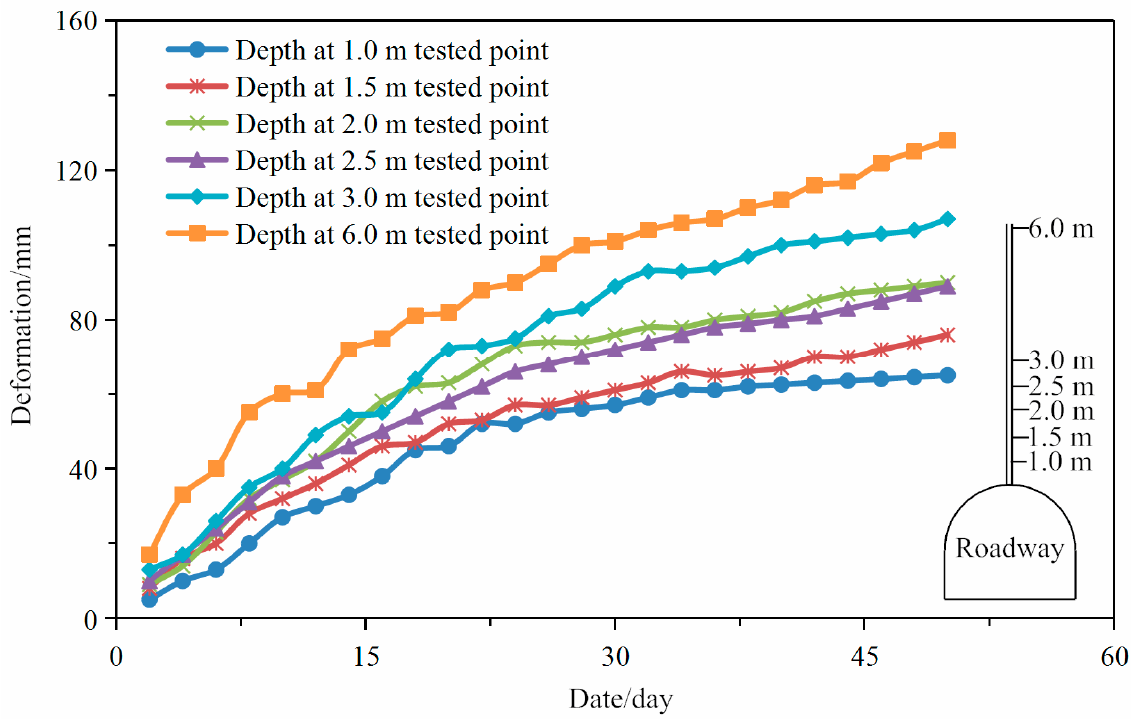
Figure 5. Displacement curve of deep surrounding rock in the roof with the initial support.